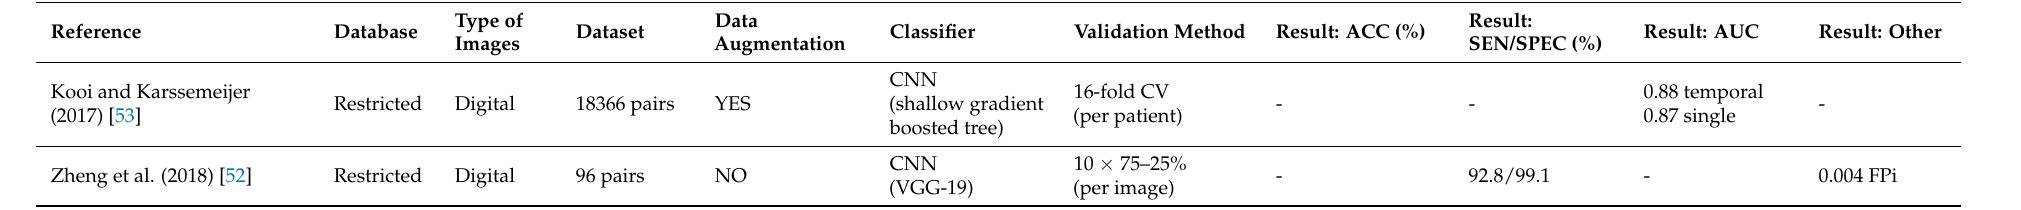
Table 3. Comparison of algorithms for the detection of masses in sequential mammograms using temporal analysis and deep learning.